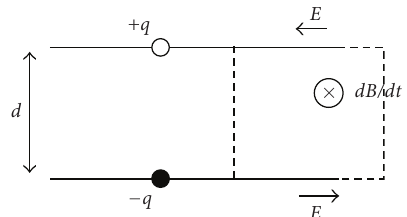
Figure 4: Schematic representaion of the e ff ect of an AC in-plane magnetic field on electrons and holes in a bilayer system with no